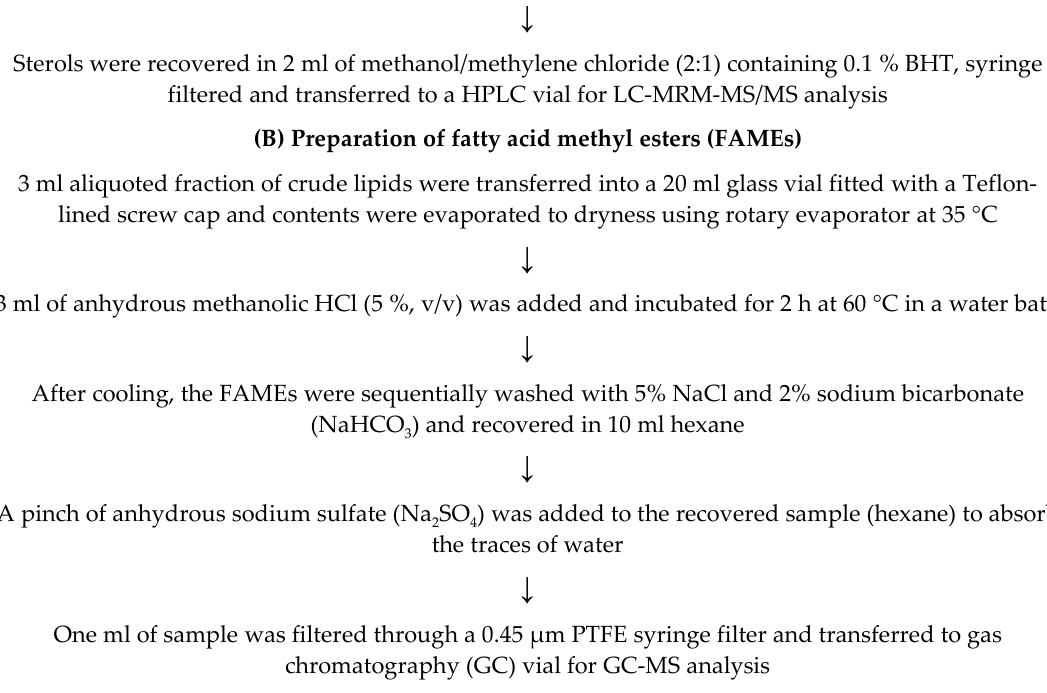
Figure 2. ( A ) Method for hydrolysis of crude lipid extract for sterols analysis, and ( B ) preparation of fatty acid methyl esters (FAMEs).